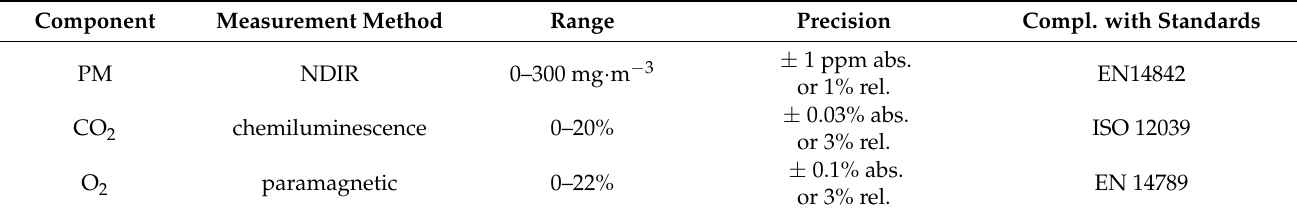
Table 6. Technical data of the Testo 380